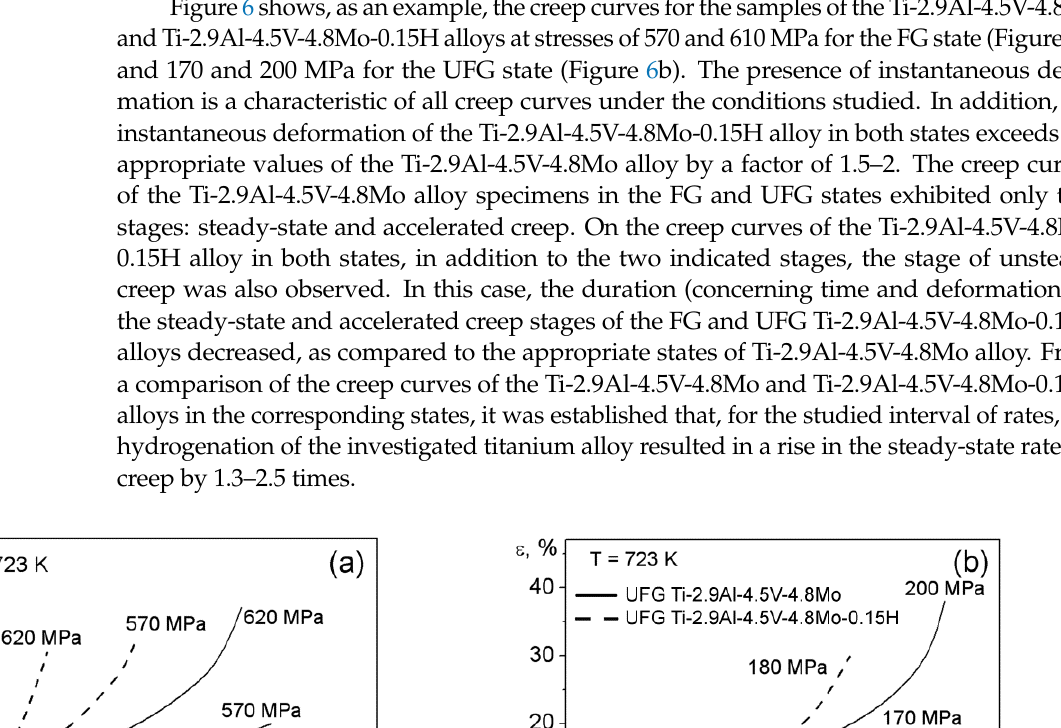
Figure 7. Experimental dependences of the steady creep rate on the stress of the FG and UFG tita- nium alloys. It follows from the slopes of the curves of the steady creep rate ε  on the applied stress in the double-logarithmic coordinates (Figure 7) that the stress sensitivity indices n were equal to 6.3 and 5.6 for the Ti-2.9Al-4.5V-4.8Mo alloys in the FG and UFG states, respectively. The high values of the n index for the Ti-2.9Al-4.5V-4.8Mo alloy are con- sistent with the data of creep investigation for other titanium alloys that were under conditions similar to the applied test conditions [43–47]. The obtained values of the stress sensitivity index n indicate that the creep of the titanium alloy in both states and under